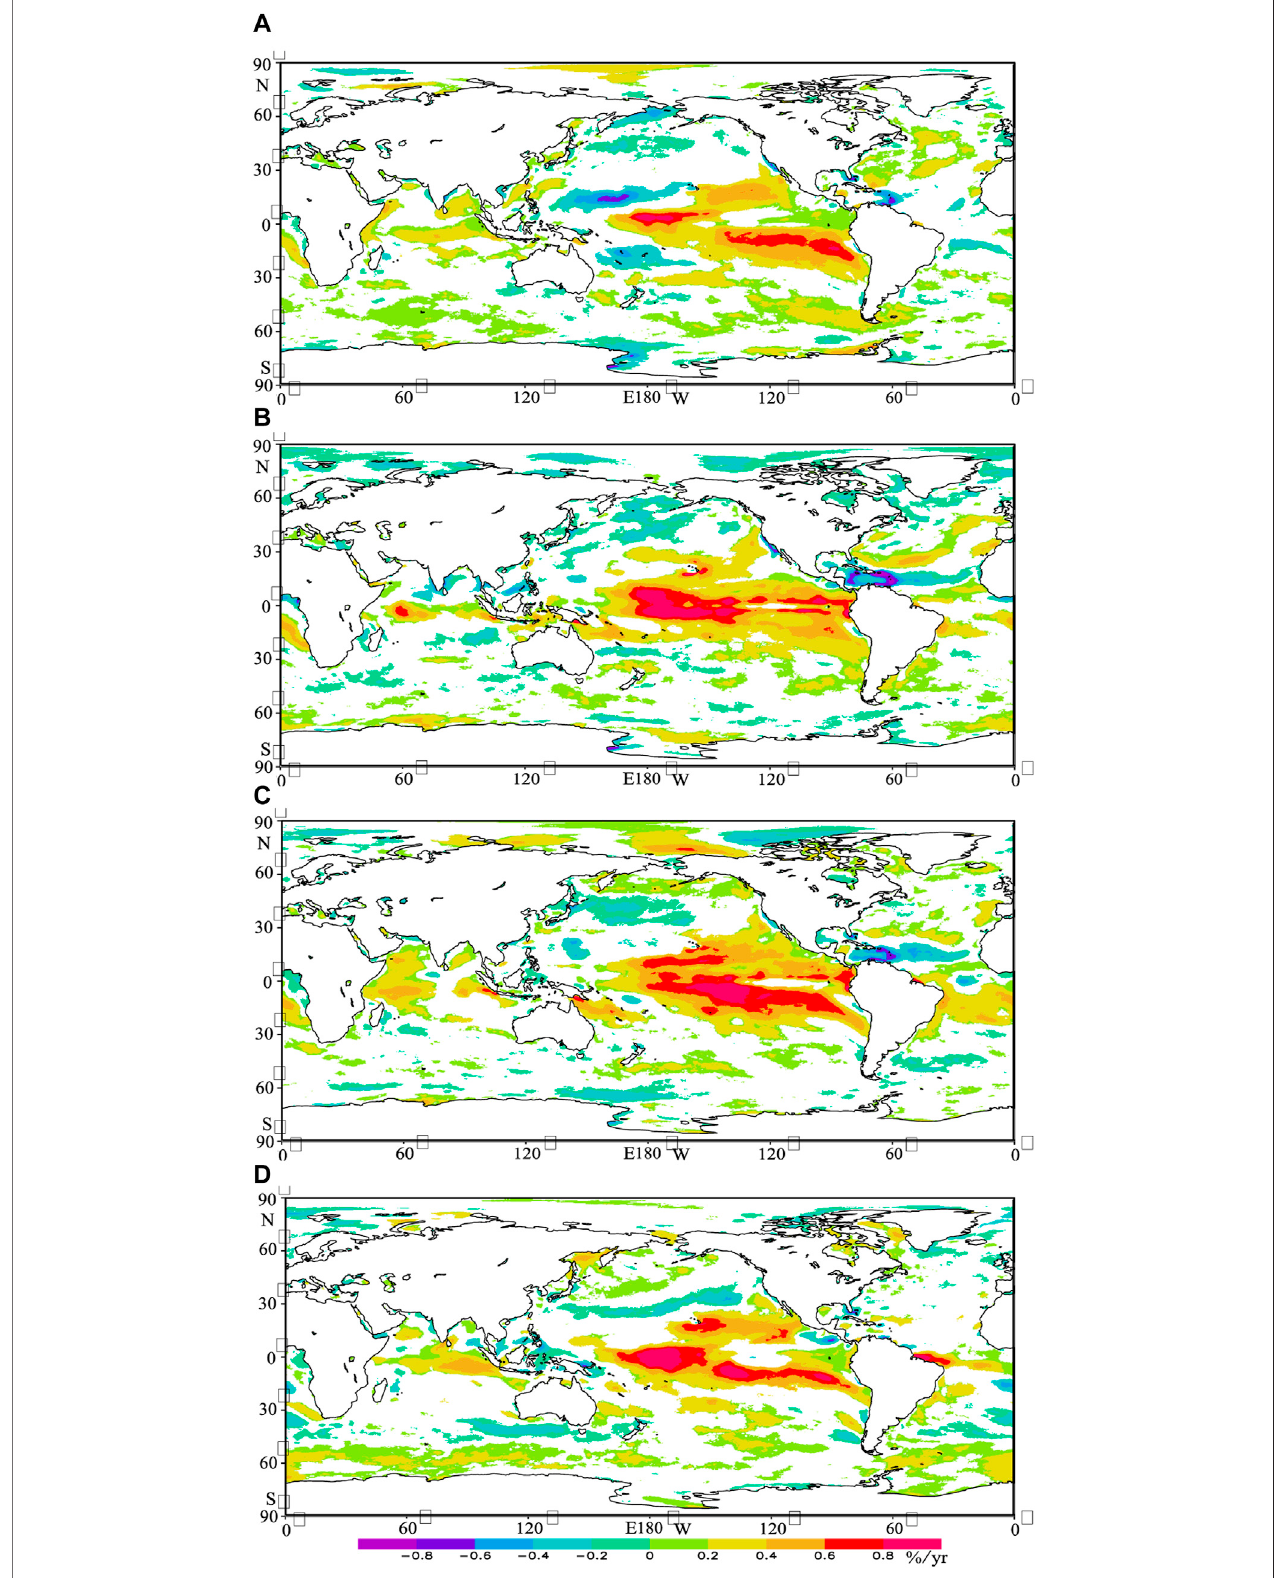
FIGURE 8 | Climatic trends of the rich level occurrence in MAM (A) , JJA (B) , SON (C) , and DJF (D) in the global ocean. Only area signi fi cant at 95% level is presented.